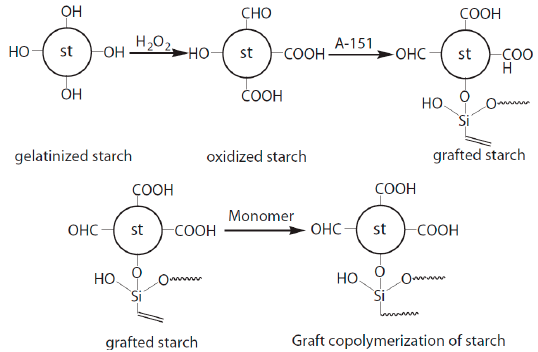
Figure 4. Reaction pathway for the synthesis of starch-based adhesive [88], Reproduced with permission from Elsevier.